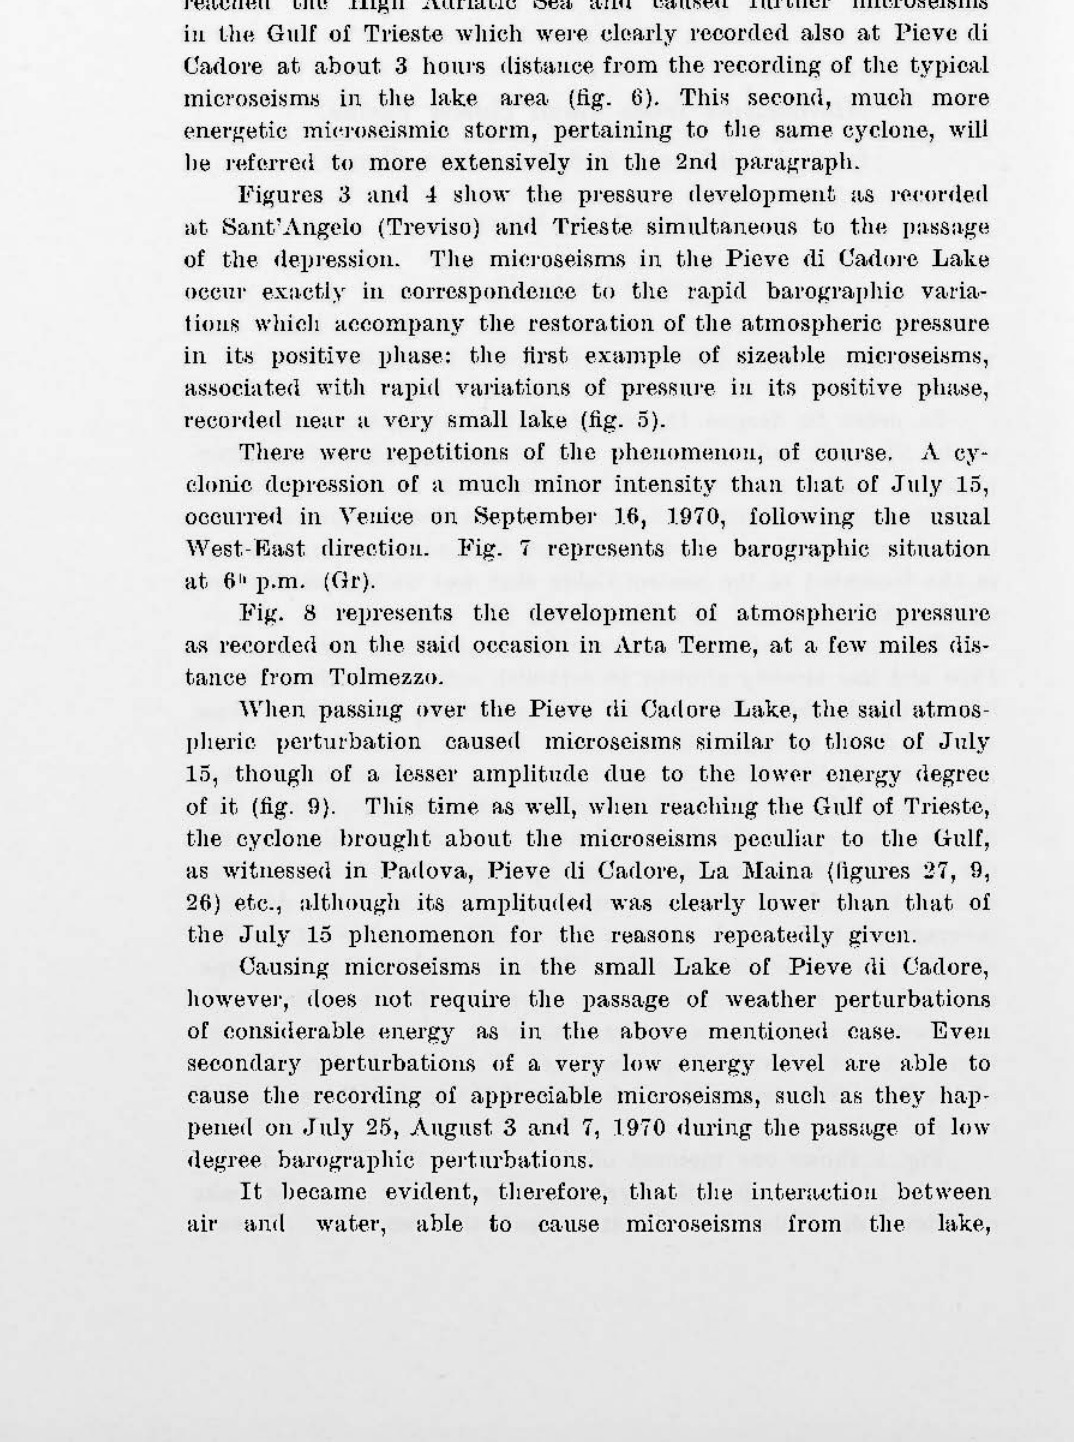
Fig. 7 I"epresent.s t,he barogmphic